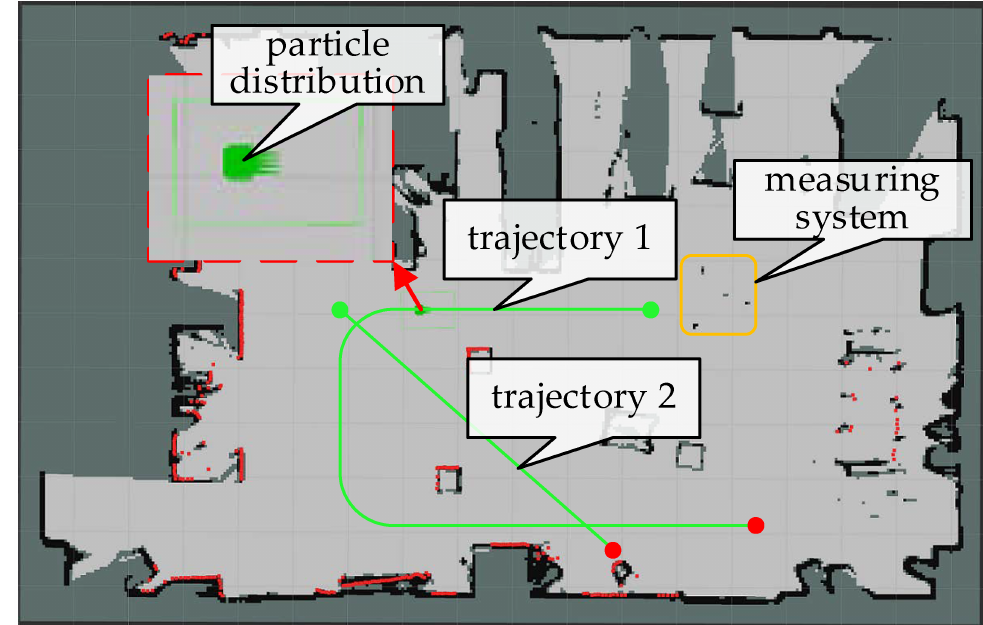
Figure 20. Robot’s two test